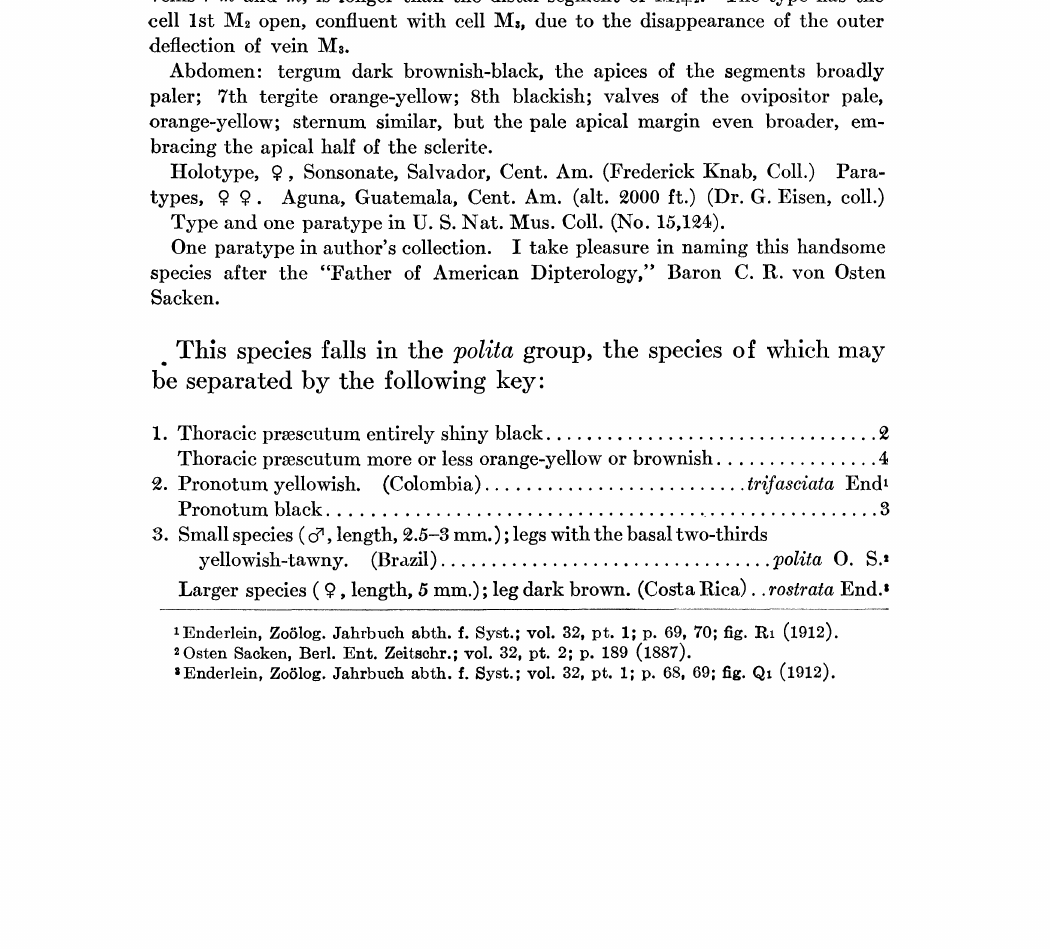
Pronotum black yellowish-tawny. (Brazil) polita O.